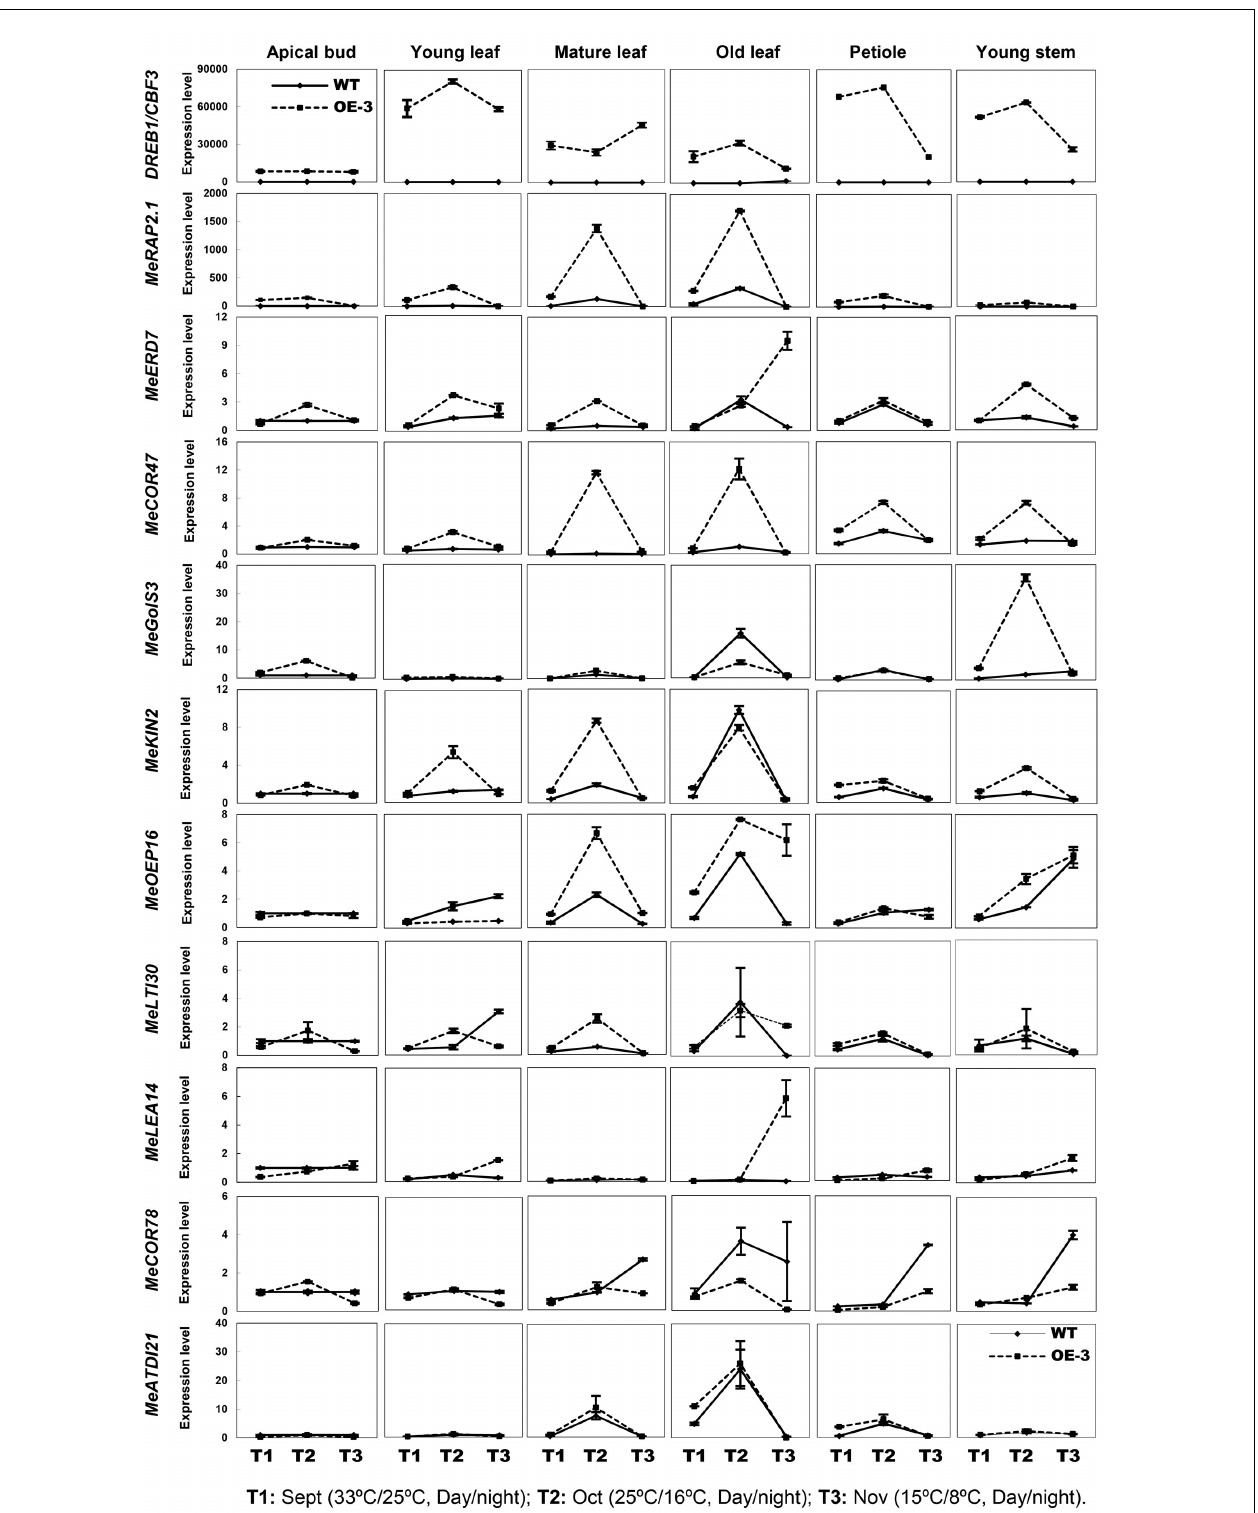
FIGURE 5 | Expression patterns of Arabidopsis CBF3 and alleged members of CBF-regulon in cassava under the seasonal temperature changes. Six different tissues of WT and the OE-3 transgenic plants were used, including apical bud, young leaf, mature leaf, old leaf, petiole, and young stem. Description of cassava genes is listed in Table 1